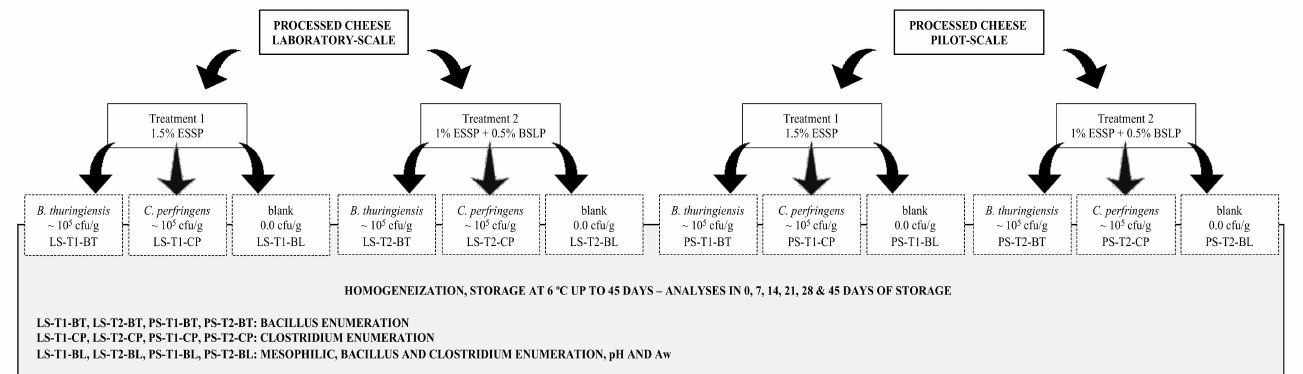
Figure 1. Flow chart of procedures employed in the production of processed cheese samples and the application of treatments to assess the inhibitory activity of emulsifying